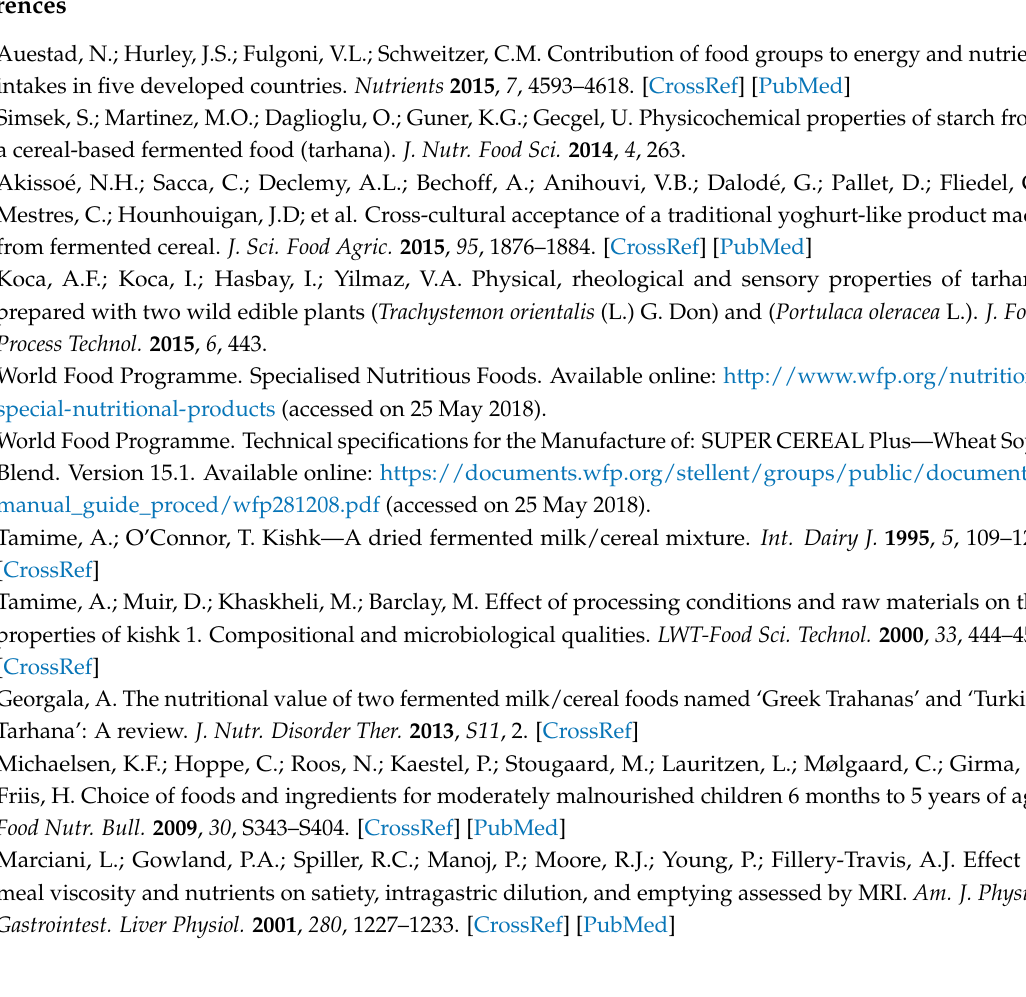
Supplementary Materials: The following are available online at http://www.mdpi.com/2304-8158/7/7/113/s1, Figure S1: Sorption isotherms for salted dehydrated fermented milk-wheat composites (FMWC) during desorption (a) and adsorption (b): The ratio of fermented milk-to-wheat composites was 1.5 ( (cid:78) ), 2.3 ( (cid:4) ), 3.0 ( (cid:3) ) or 4.0 ( ). Presented values are the means of two replicate trials; error bars represent standard deviations of the mean, Figure S2: DSC endotherms for salted (s) dehydrated fermented milk–wheat composites (FMWC) with different ratios of fermented milk to wheat: 1.5, 1.9, 2.3, 3.0 or 4.0, Figure S3: Pasting curves of salted (s) dehydrated fermented milk-wheat composites (FMWC) with different ratios of fermented milk to wheat: 1.5, 1.9, 2.3, 3.0 or